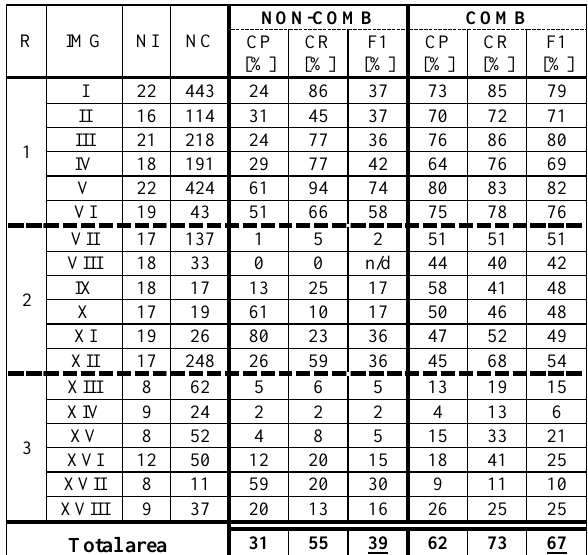
Table 1: Evaluation results for the non-combined and combined detection results; (n/d: not defined).